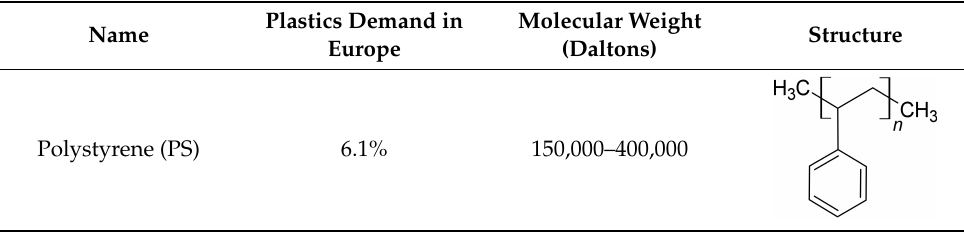
Table 7. European plastic demand, molecular weight (Daltons) and backbone structural formula of polypropylene.